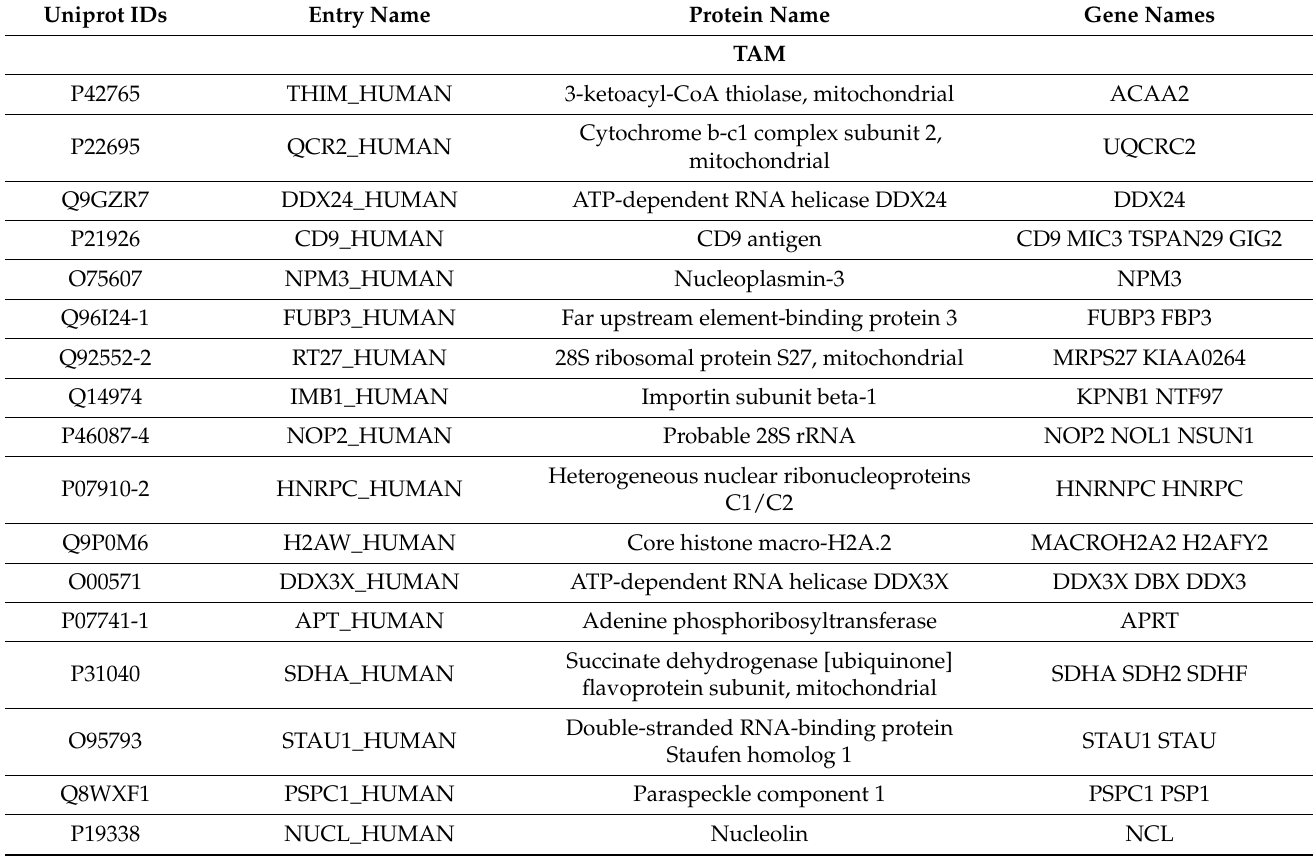
Table 1. Proteins found to be uniquely aggregated in MCF-7 cells following 24 h incubation with 4OH-tamoxifen (TAM) or Fulvestrant